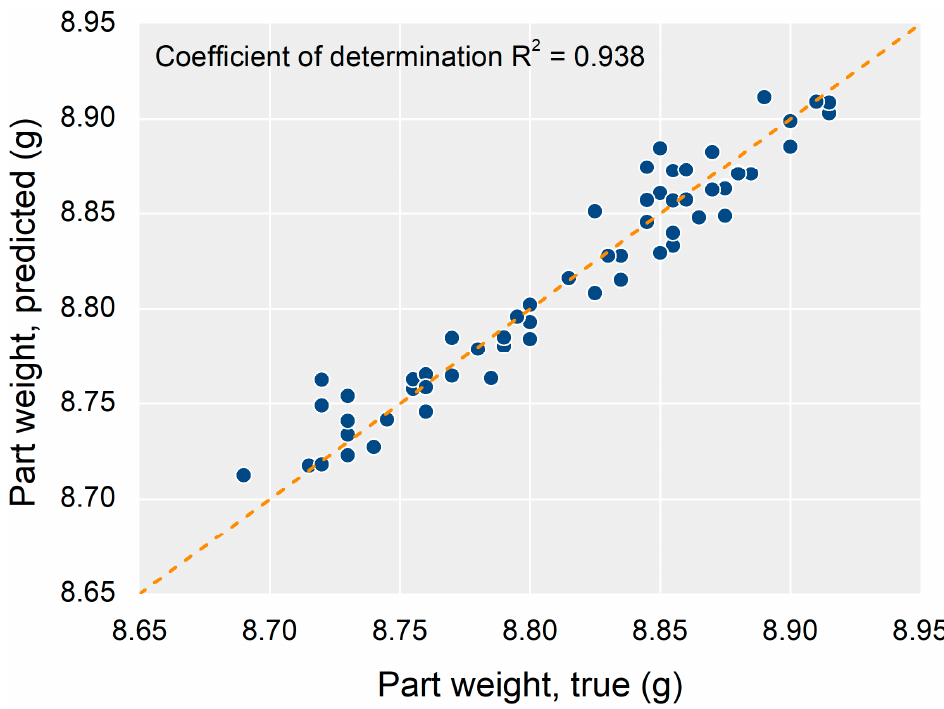
Figure 8. Part weight prediction result by the neural network.